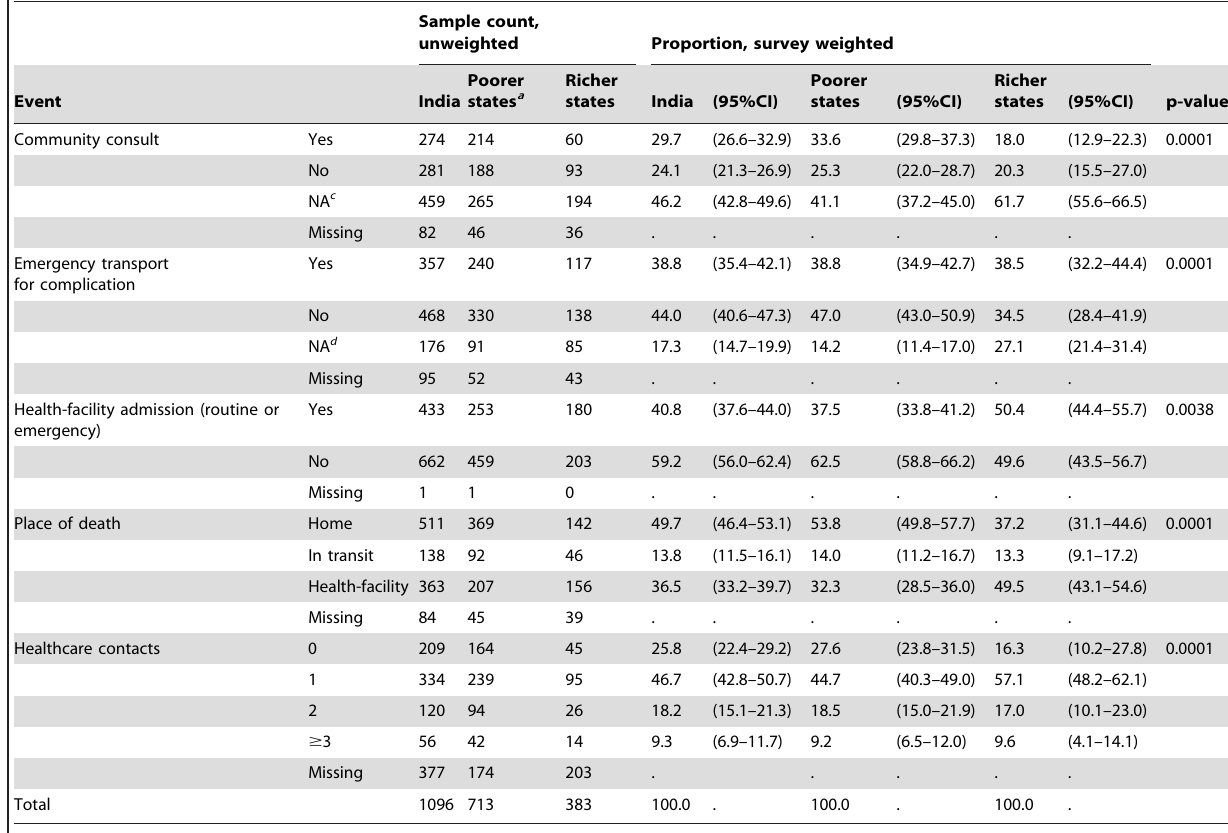
Table 4. Emergency service uptake in 1096 maternal